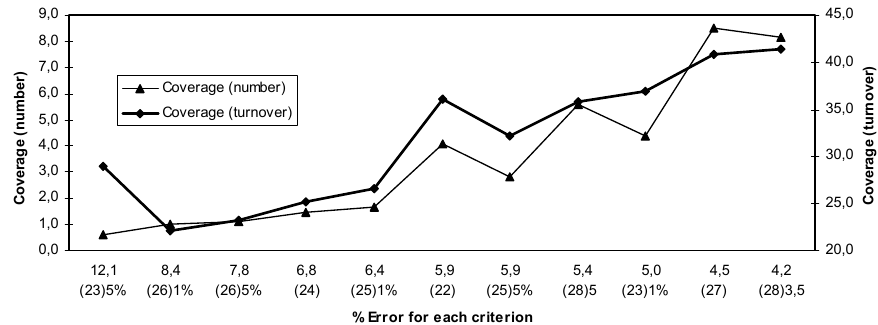
Figure 2 – Estimate errors and coverage using Ф 2 and option a), formula (2) – Change